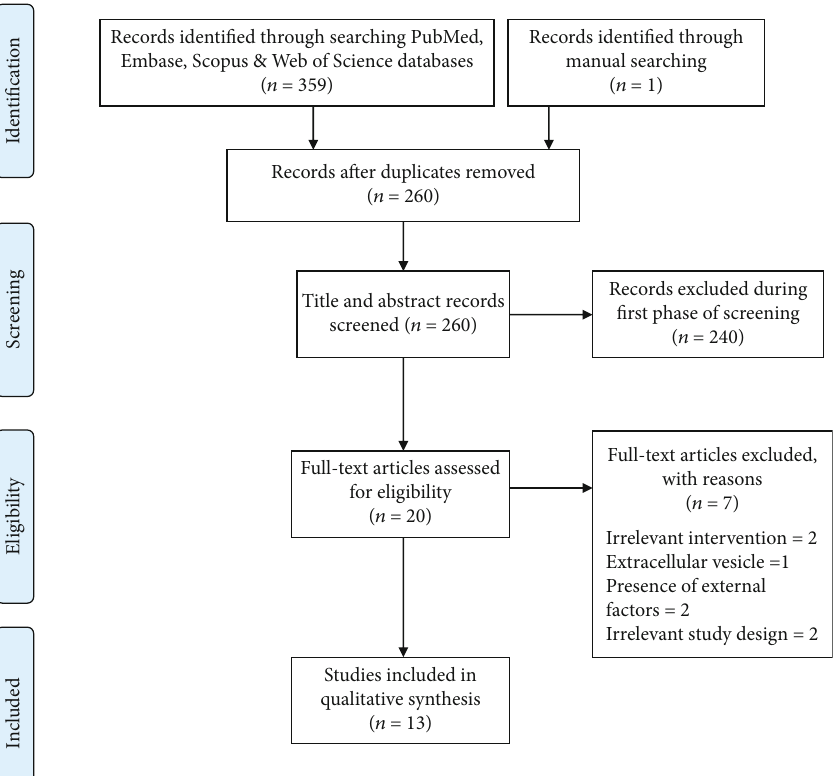
Figure 1: Flow diagram showing the di ff erent phases of literature screening for the scoping review process. (Editable fi le: PRISMA Flow Diagram, Liberati et al.,